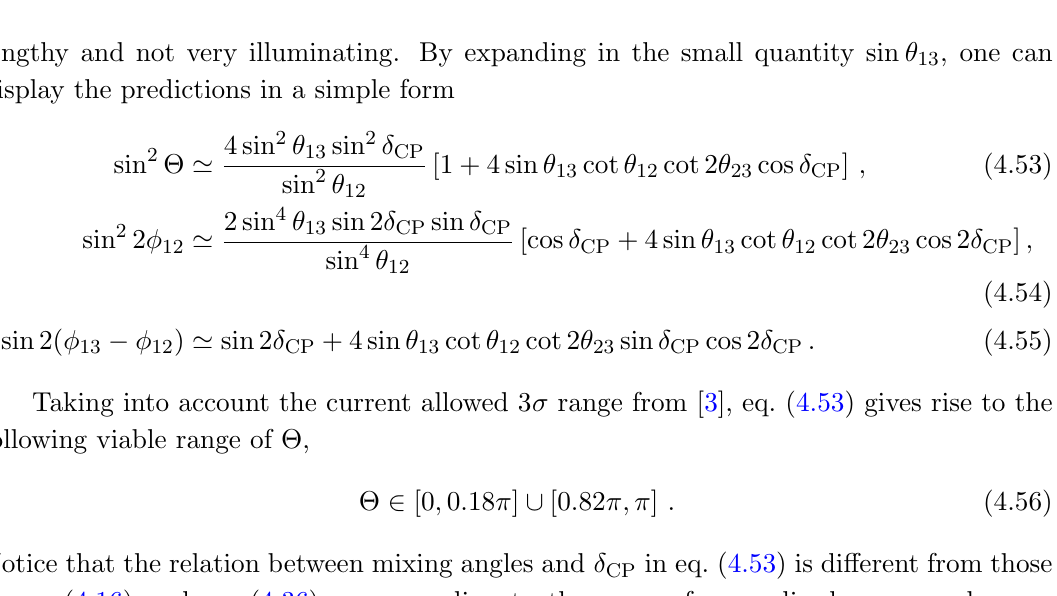
Table 3 . Numerical examples for the eneralized (cid:22) (cid:0) (cid:28) re(cid:13)ection, where we assume (cid:12) = (cid:13) = 0. The values of (cid:2) and (cid:18) 1 ; 2 ; 3 are (cid:12)xed by the best (cid:12)tted value of mixing angles and experimentally favored value (cid:14) CP = 3 (cid:25)= 2 [6, 7]. Notice that the two Majorana CP phases are predicted , as shown in the